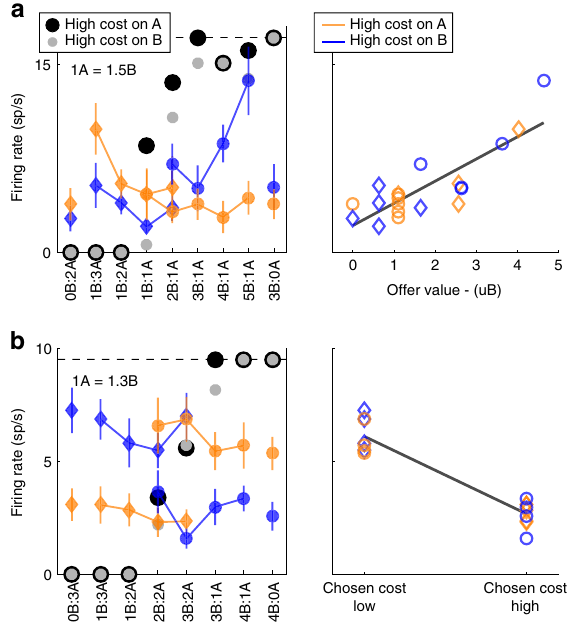
Fig. 3 Encoding of decision variables in cost-based reference frame. a Neuronal response encoding the variable offer value − (post-offer time window). In the right panel, the neuronal response is plotted against the variable offer value − expressed in units of juice B. The black line is derived from a linear regression ( R 2 = 0.69). b Response encoding the variable chosen cost (pre-juice time window). In the right panel, the black line is derived from a linear regression ( R 2 = 0.88). All conventions are as